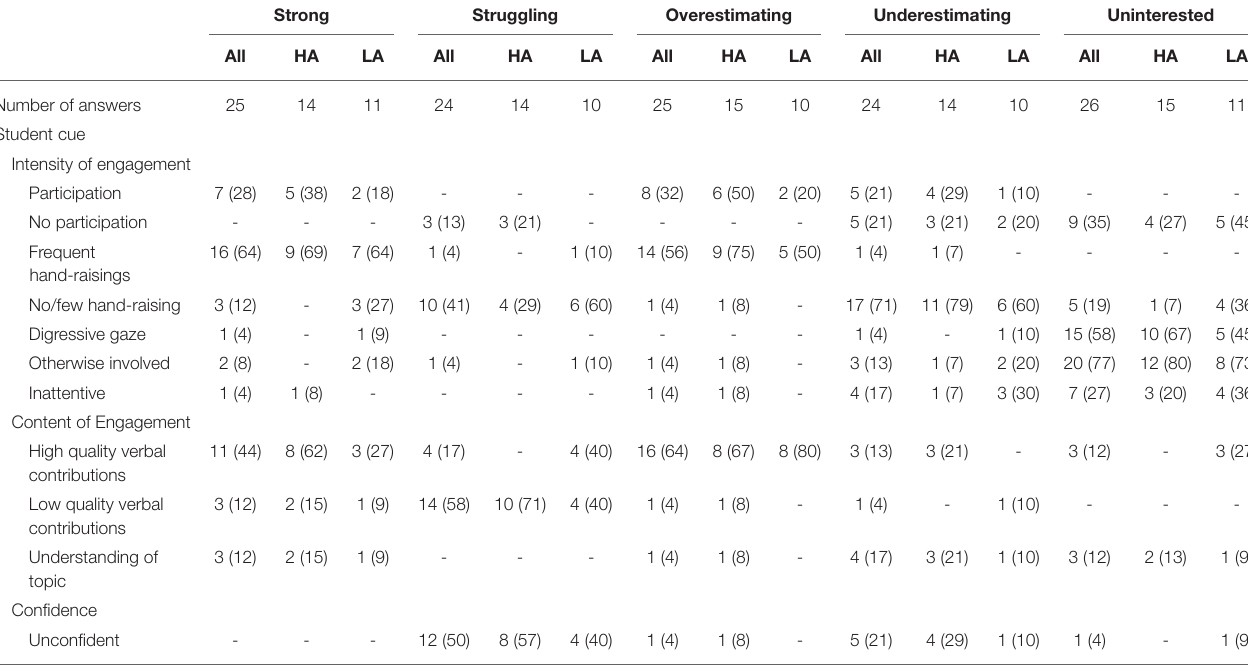
TABLE 5 | Absolut and relative frequencies of utilized student cues for student teachers with high and low judgment accuracy across student